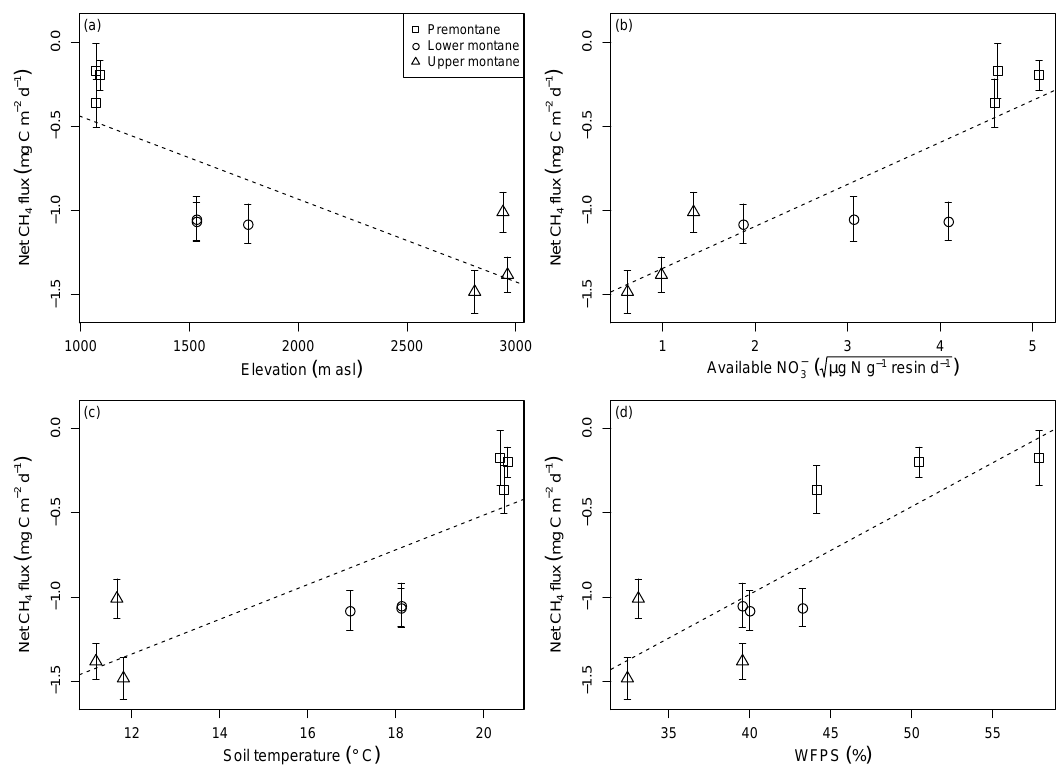
Figure 4. Relationships between dataset plot means of net CH 4 flux and (a) elevation, (b) square-root transformed available NO − temperature and (d) WFPS across forest types. Error bars indicate standard error. Dashed lines indicate linear regression models between